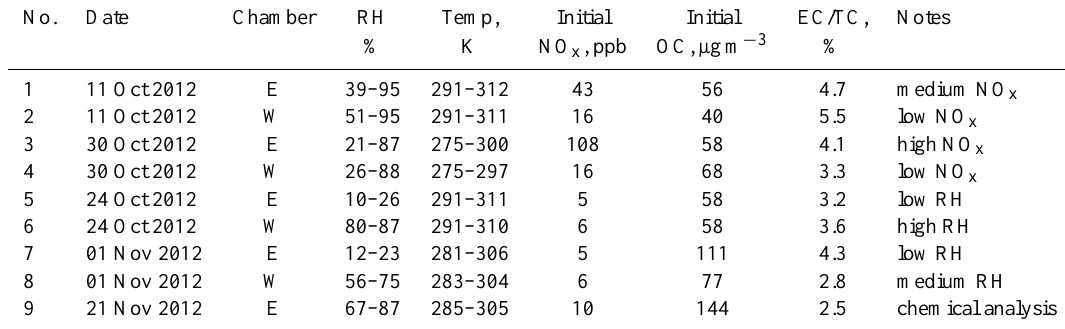
Table 1. Summary of experimental conditions of fresh wood smoke before photochemical